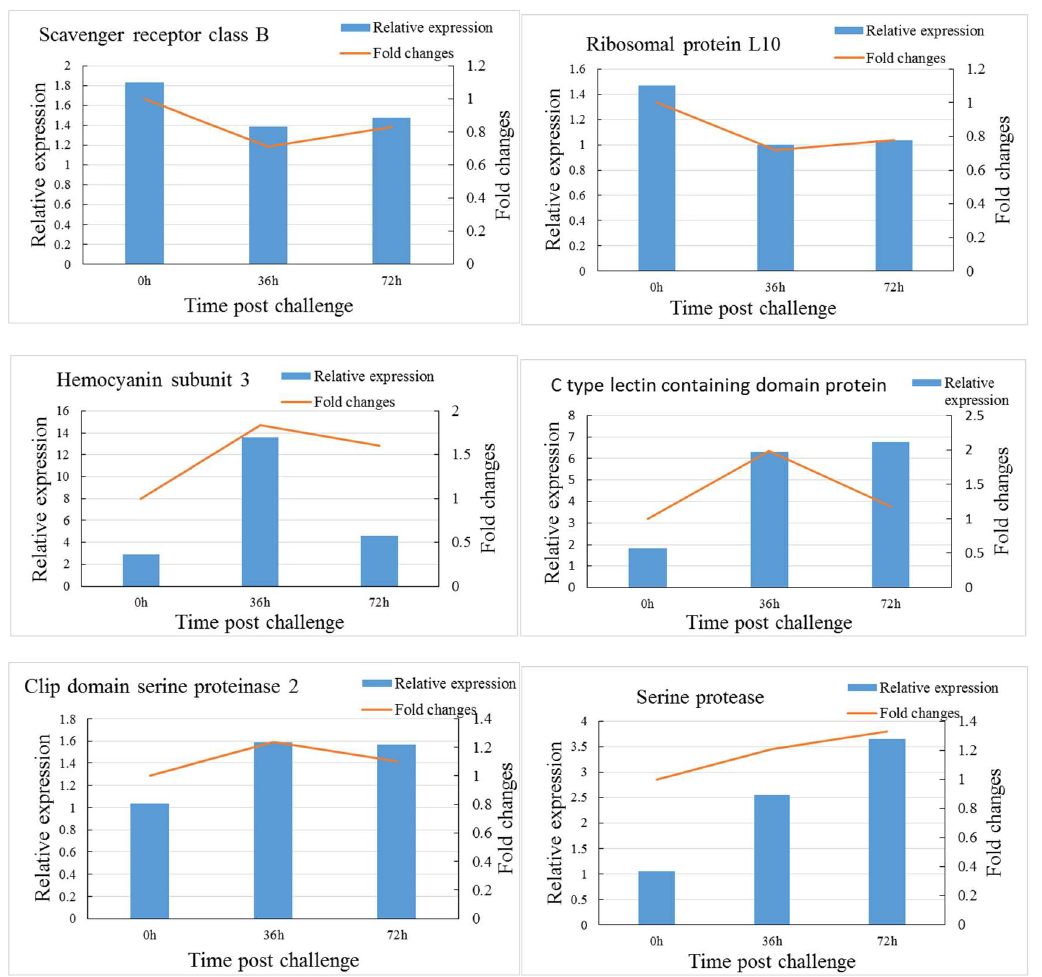
Figure 7. Comparison of transcriptional analysis and iTRAQ-based proteomic results for six differentially expressed proteins.